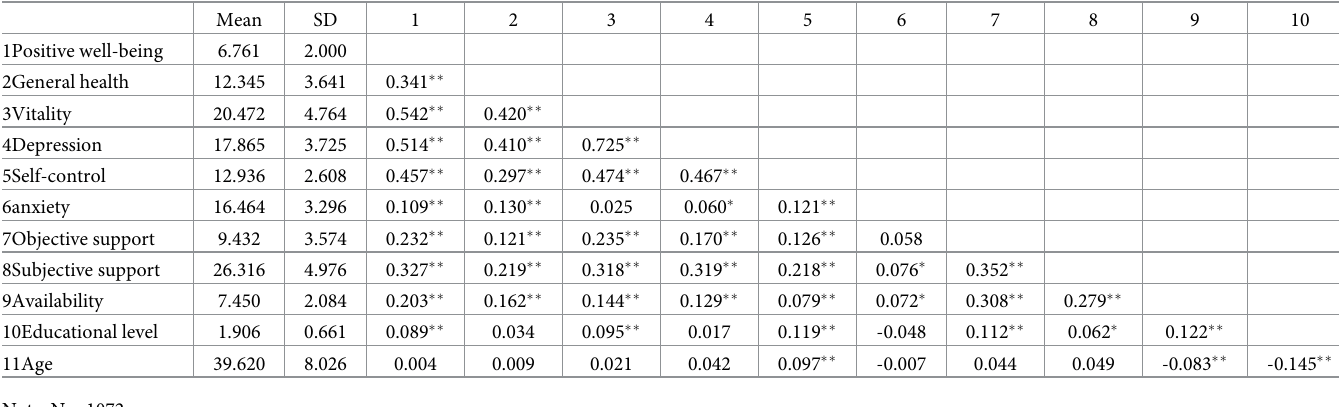
Table 1. The mean, standard deviation and correlations between variables of interest.